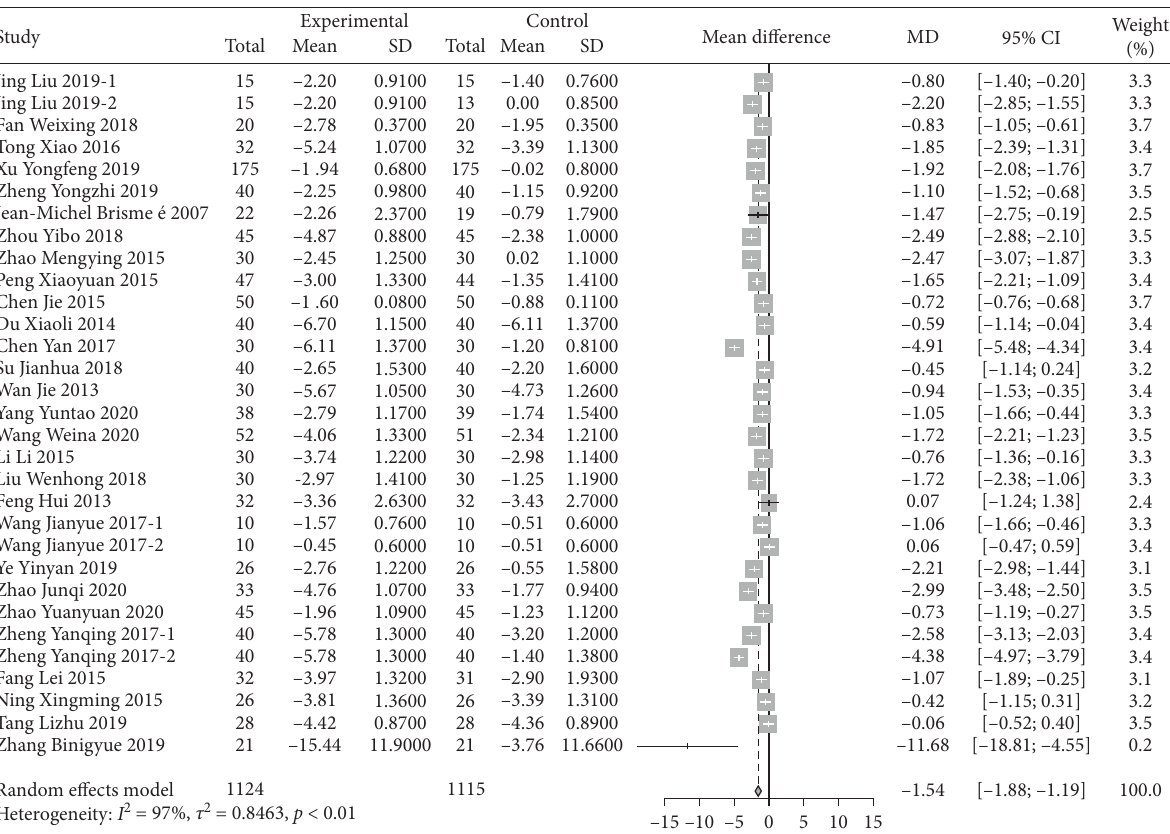
Figure 3: Meta-analysis of the comparison of VAS between the traditional Chinese exercise group and the control